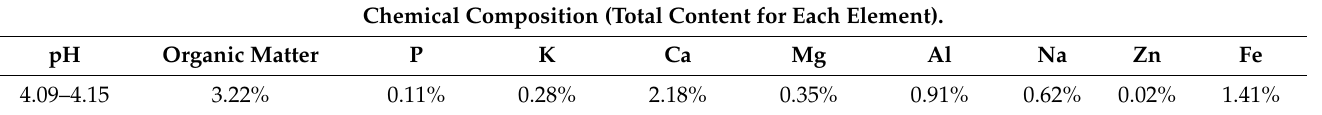
Table 1. Chemical composition of the soil before the experiment. Chemical Composition (Total Content for Each